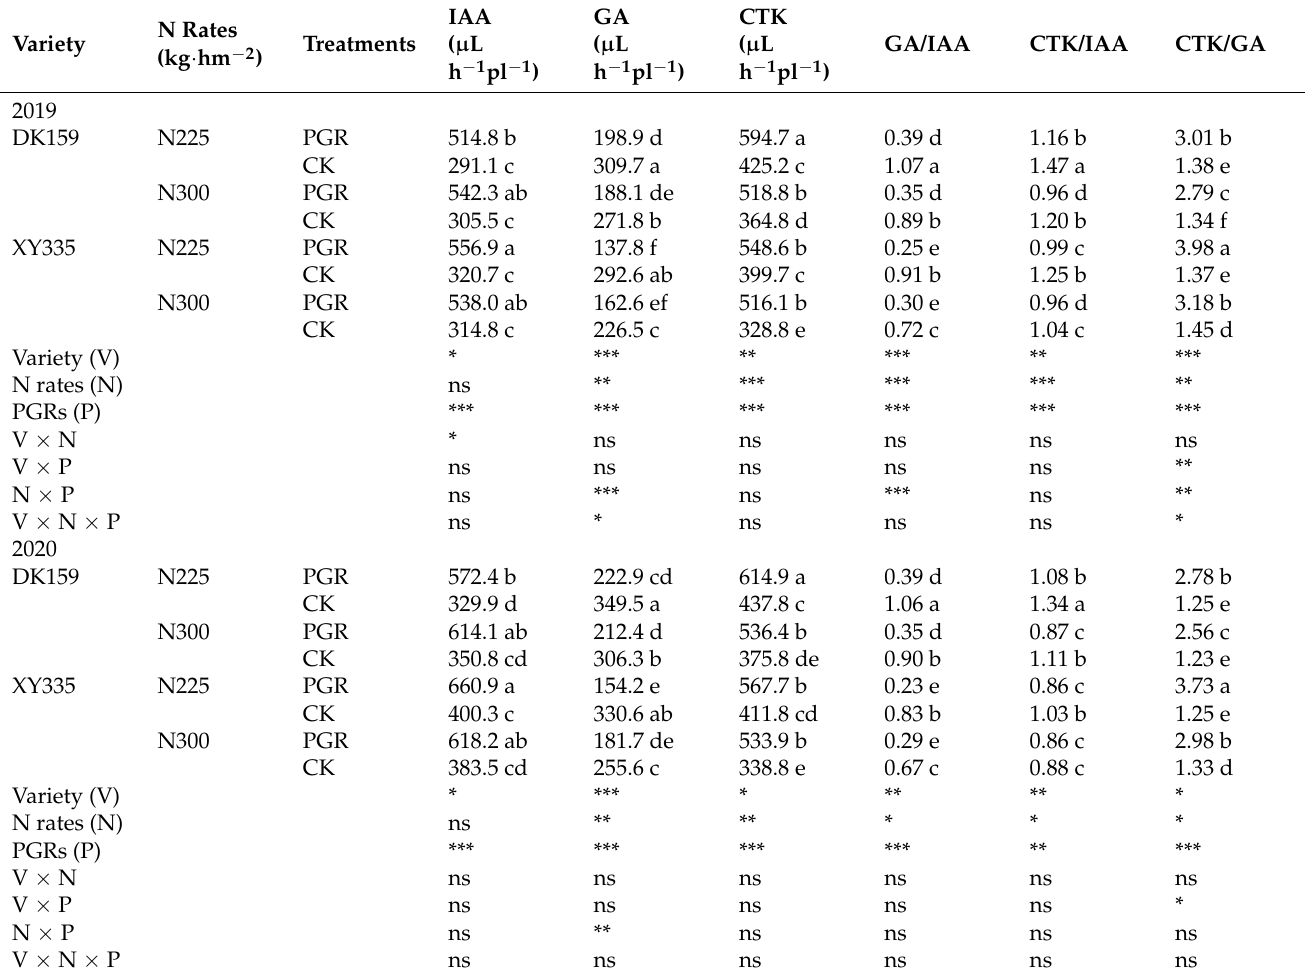
Table 4. Effects of PGRs and nitrogen fertilizer on the endogenous hormones of root bleeding